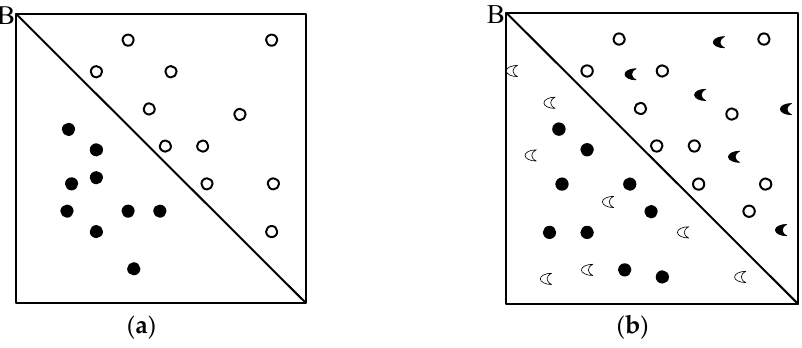
Figure 16. ( a ) The classic SVM model; ( b ) the SVM multiple-classification model.